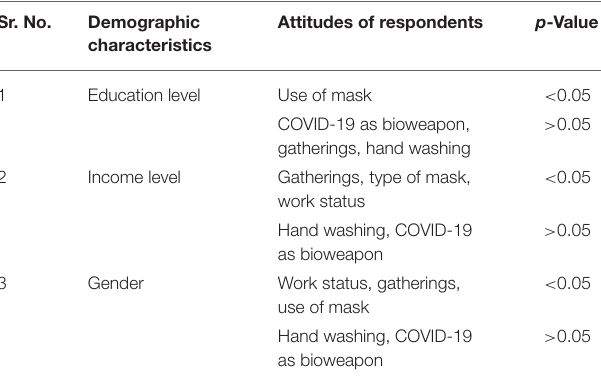
TABLE 3 | Statistical Significance between participants’ demographic characteristics and their responses. Sr.